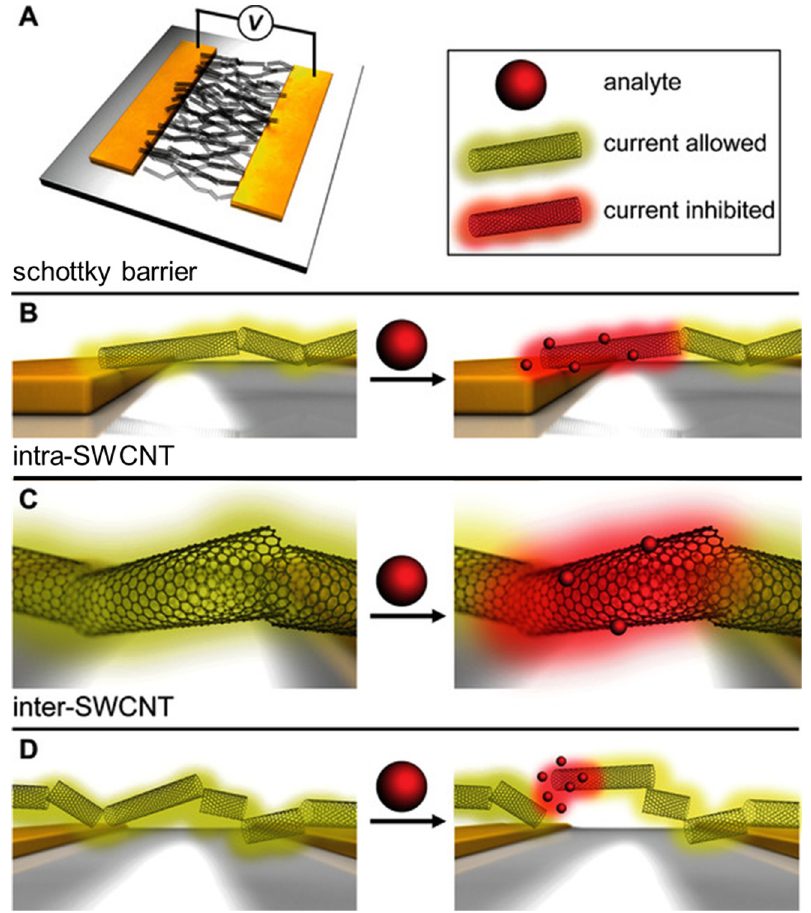
Figure 4. ( A ) Schematic of sensing mechanisms in SWCNT network-based resistive sensors; ( B ) at the interface between the metallic electrode and the SWCNT (Schottky barrier); ( C ) at the sidewall or along the length of the SWCNT (intra-SWCNT); ( D ) at the SWCNT − SWCNT interface (inter-SWCNT). Reproduced with permission from Ref. [37]. Copyright 2016 John Wiley and Sons.